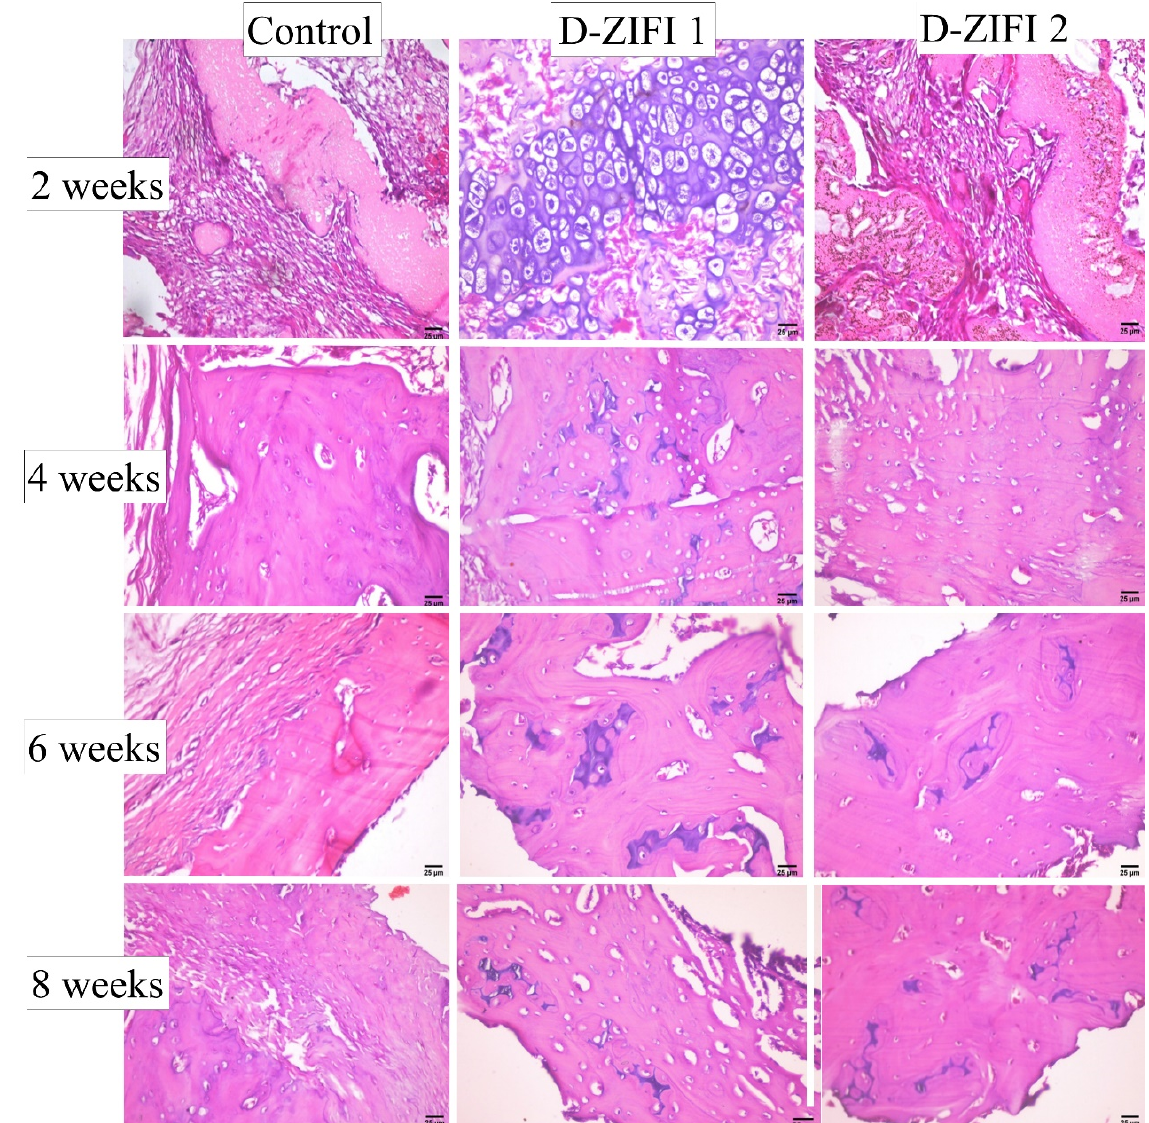
Figure 9. Histological sections of punctures in the tibia of rats stained with hematoxylin and eosin at magnification 40X of non-treated tibial puncture, tibial puncture treated with D-ZIFI 1, and tibial puncture treated with D-ZIFI 2 after 2, 4, 6, and 8 weeks of treatment.